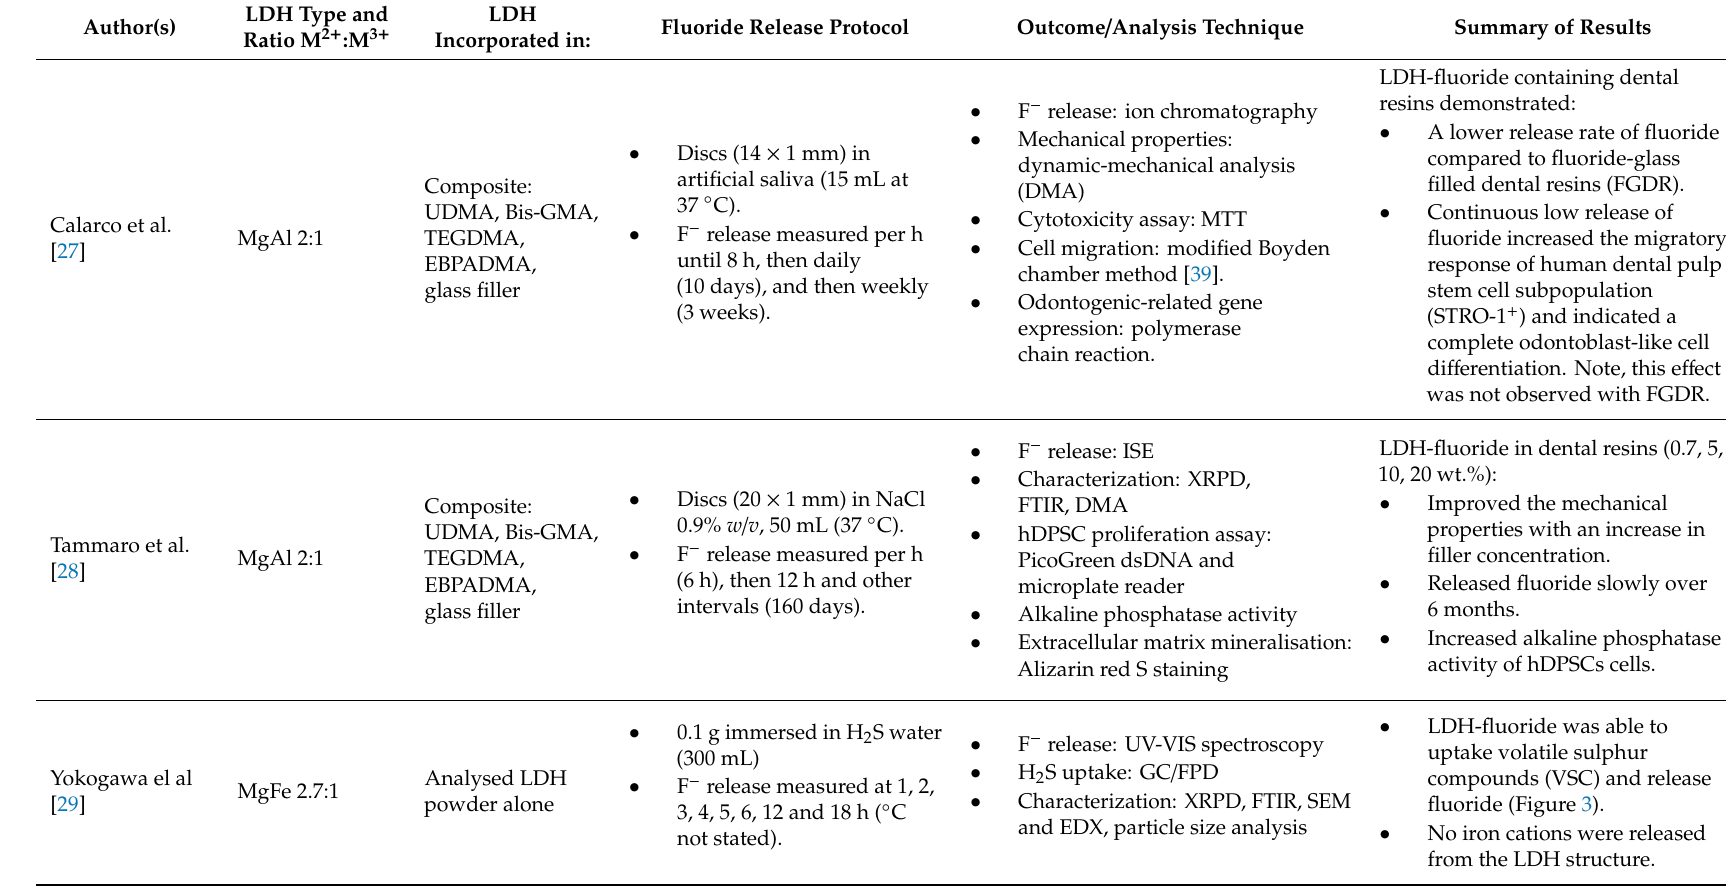
Table 4. Characteristic details and summary of results from studies identified in the systematic